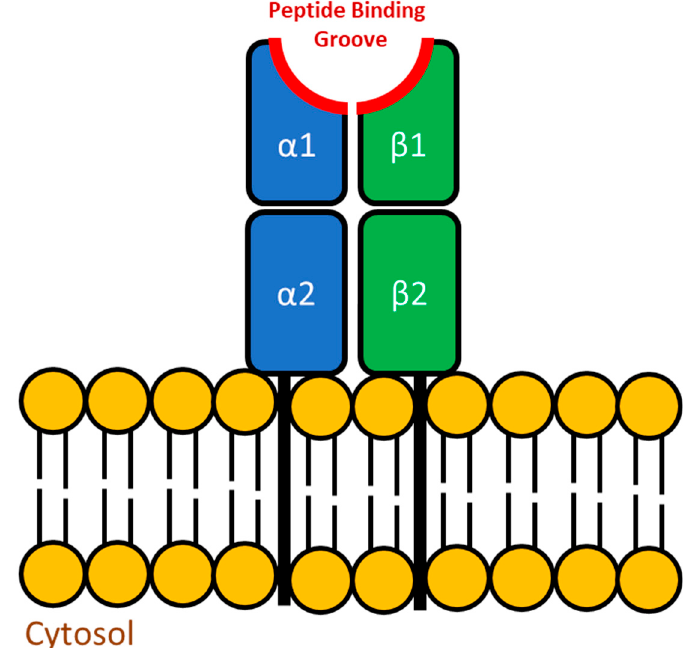
Figure 2. Structure of the MH class II molecule. The structure and function of the teleostean MH class II dimer is very similar to mammalian MHC class II. The molecule is a dimer, consisting of an alpha chain and beta chain, both of which have transmembrane regions. As outlined in red, both the α 1 and β 1 domains of this molecule have a hypervariable region that is part of the peptide binding groove. It is this region that is capable of binding to compatible antigens and presenting it to T cells.